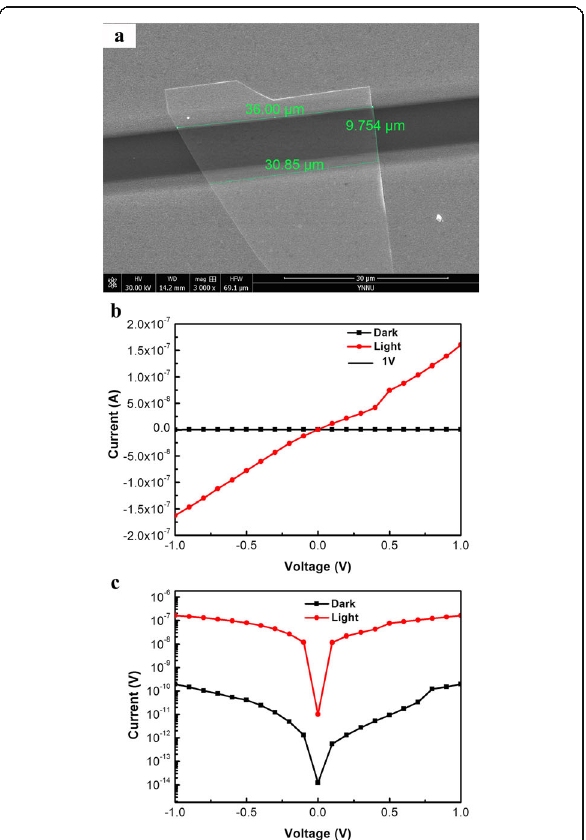
Fig. 7 SEM image and I – V curves of a single CdSSe NB detector. a SEM. b I – V curves under dark conditions and white light illumination with power density of 43.14 mW/cm 2 . c I – V graph obtained after taking logarithm